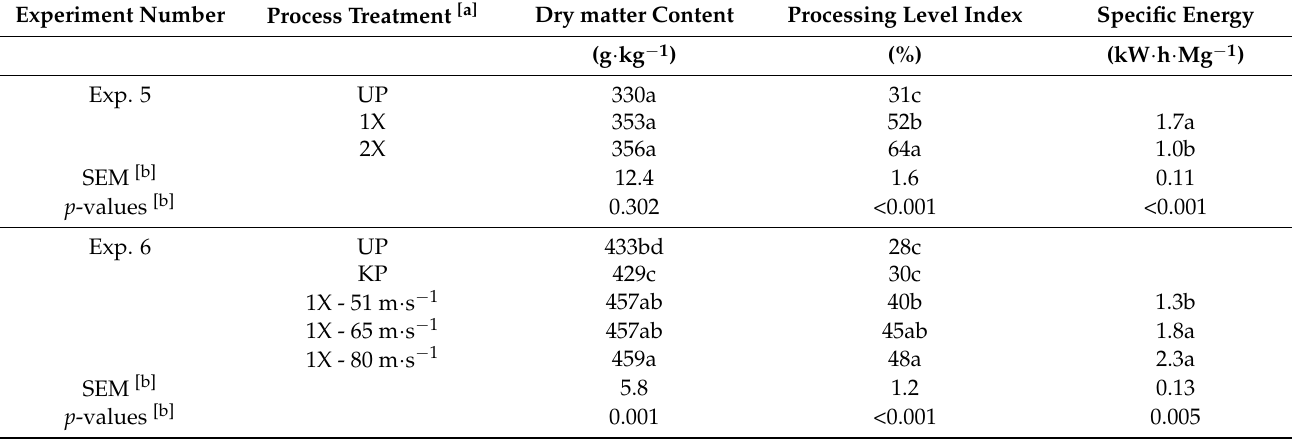
Table 5. Specific energy requirements (on as-processed moisture basis) for processing whole-plant corn with the experimental processor during Experiments 5 and 6.